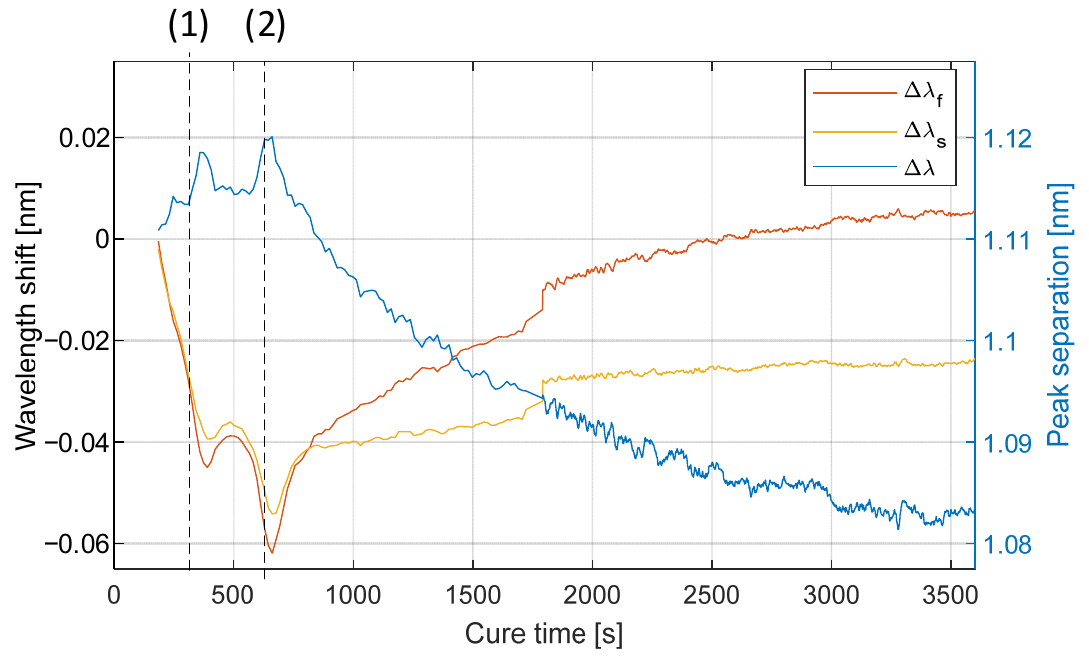
Figure 7. Bragg wavelengths and peak separation changes during the curing process; (1)—gelation time determined from data of the in-mold DC sensor, (2)—deadhesion of the plate from the mold.